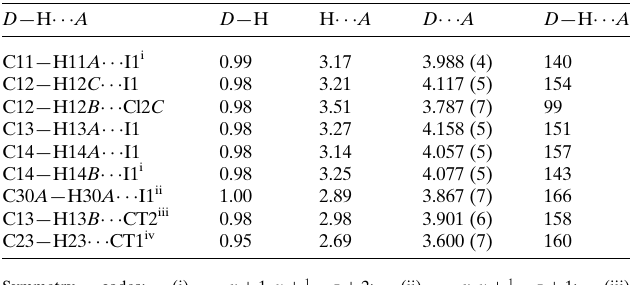
Table 1 Hydrogen-bond geometry (A˚ , (cid:4) ).